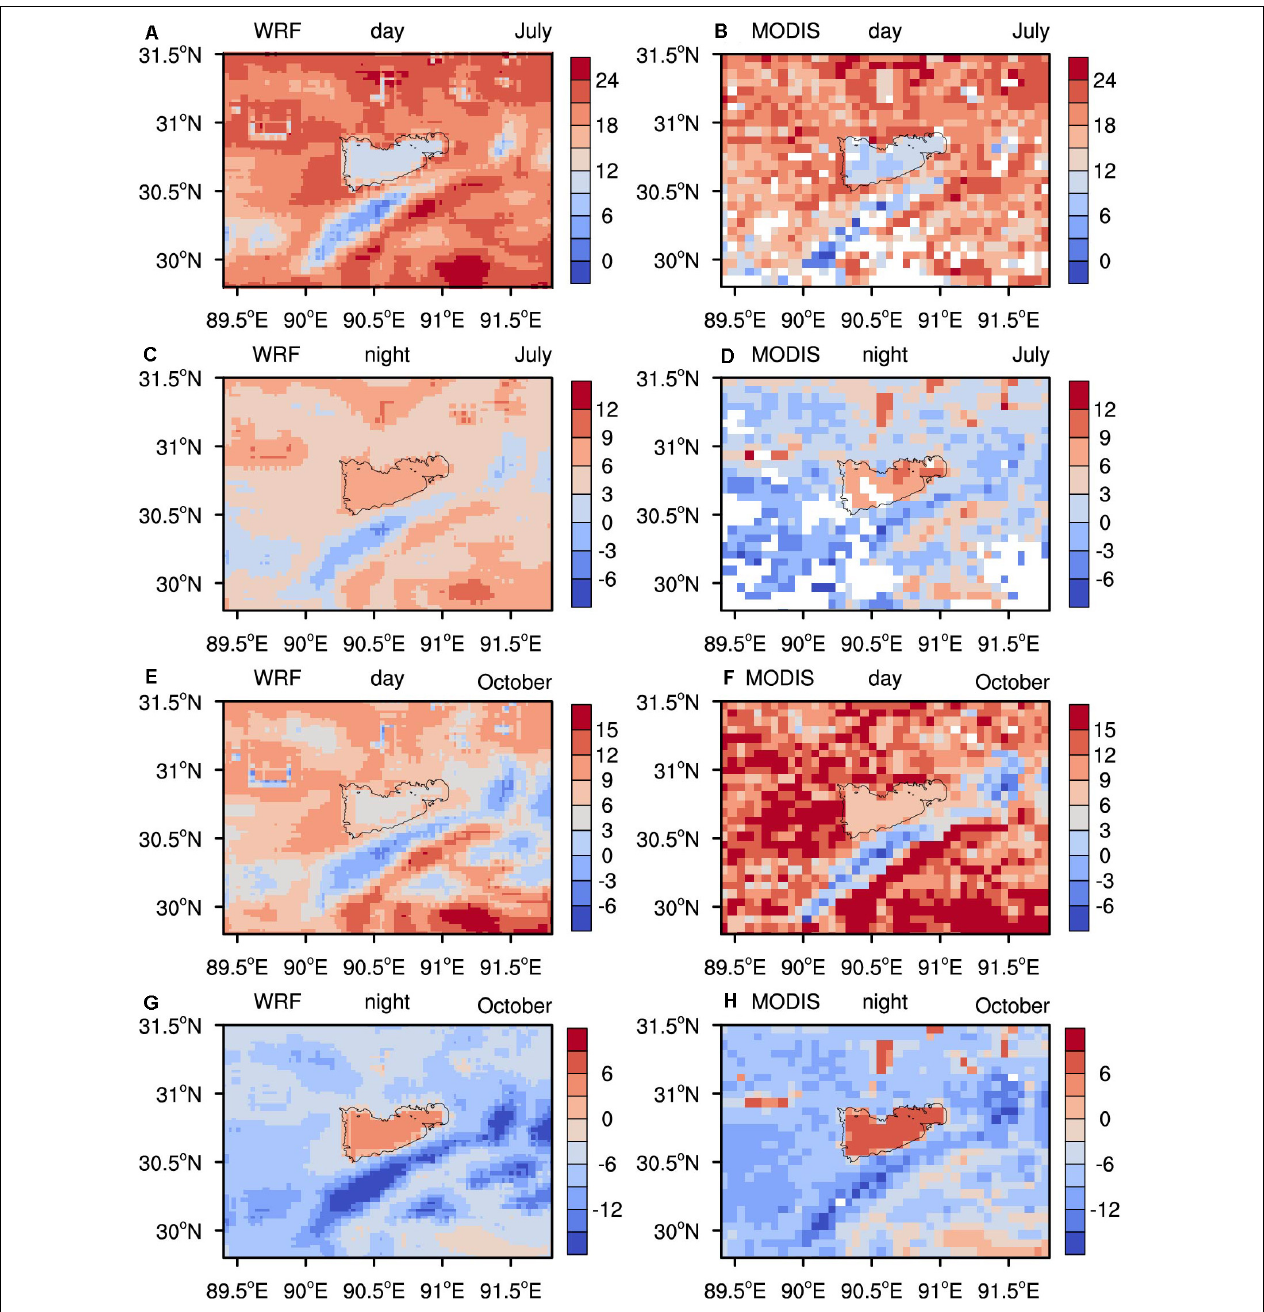
FIGURE 2 | Diurnal spatial pattern of temperature of skin surface (TSK, units: ◦ C) of WRF_lake simulation in July (A,C) and October (E,G) , and the TSK from MODIS data in July (B,D) and October (F,H) . The gridded squares with missed MODIS value are filled by white color.